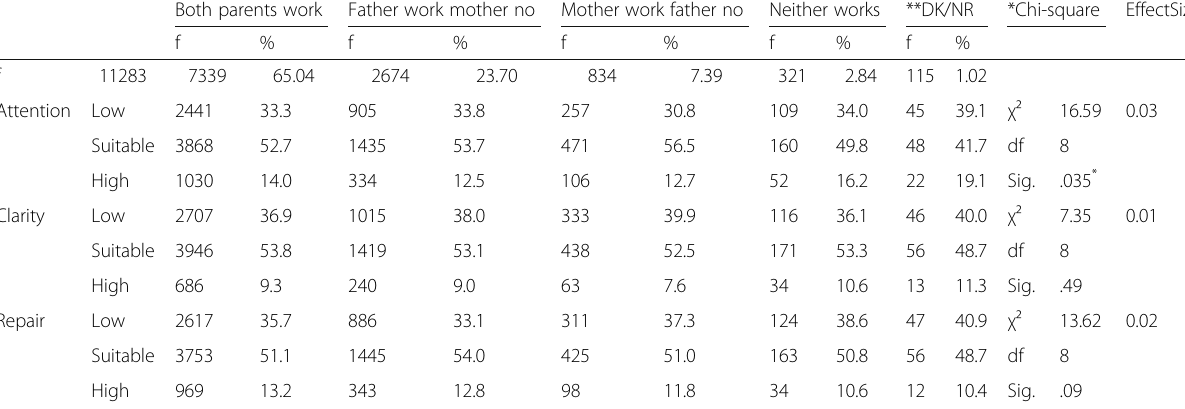
Table 6 Self-perception of emotional intelligence according to each of these groups: both parents work, only one of them works or neither works. Pearson's chi-square test and Effect sizes for Cramer ’ s V Both parents work Father work mother no Mother work father no Neither works **DK/NR *Chi-square